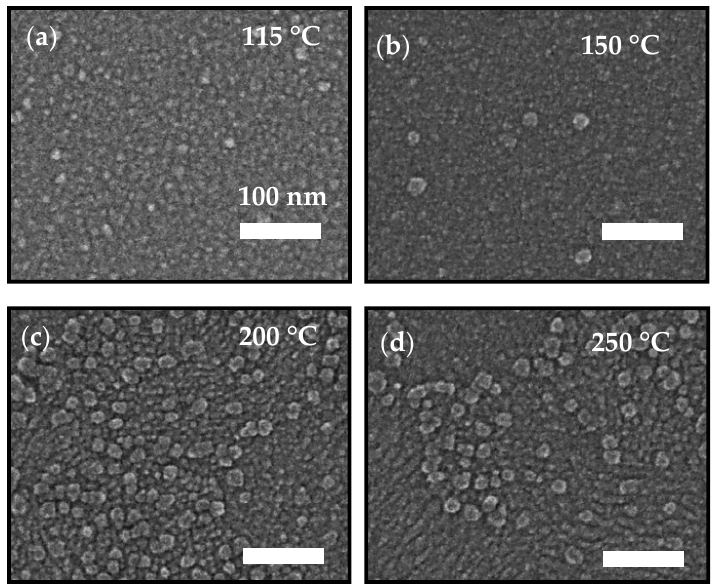
Figure 3. Plain-view SEM images of In 2 O 3 films deposited on the Si substrate at ( a ) 115 °C ( b ) 150 °C, ( c ) 200 °C, and ( d ) 250 °C. All scale bars are 100 nm.